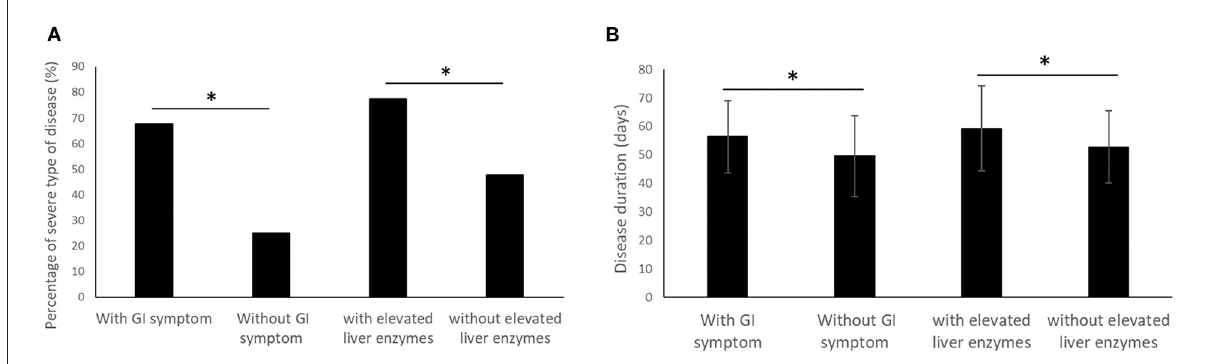
FIGURE1 Comparison of percentage of severe type of disease (A) and disease duration (B) between patients with and without GI symptom/elevated liver enzymes. (* p < 0.05).